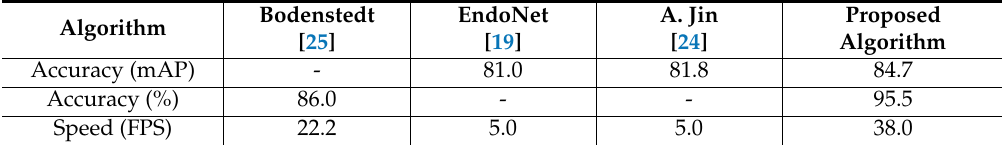
Table 3. Comparison of performance of our method with and without missing tool detection. Algorithm